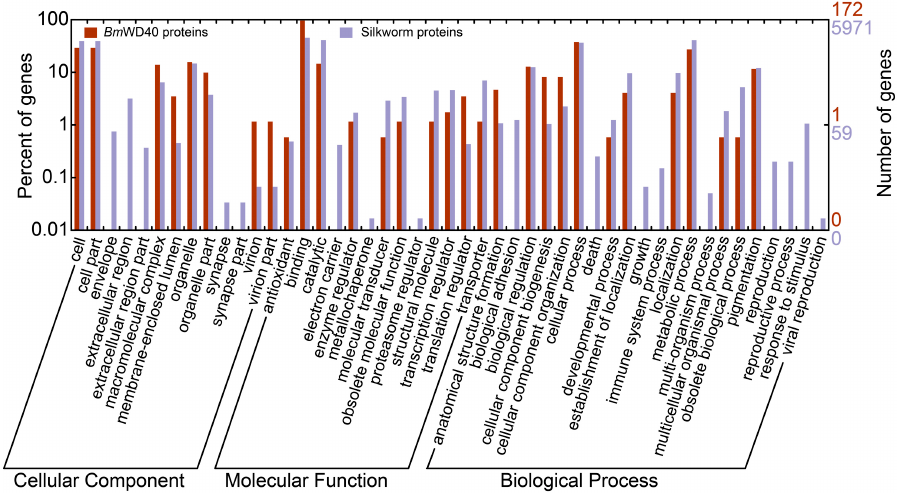
Figure 6. Gene Ontology (GO) categories of BmWD40 genes and genes with GO annotations obtained from SilkDB. This analysis was visualized with WEGO (Web Gene Ontology Annotation Plotting, http://wego.genomics.org.cn/). Details are provided in Supplementary File Table S3.